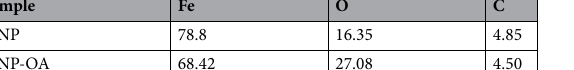
Table 4. Elemental analysis of pure magnetite (MNP) and oleic coated magnetite composite (MNP-OA).